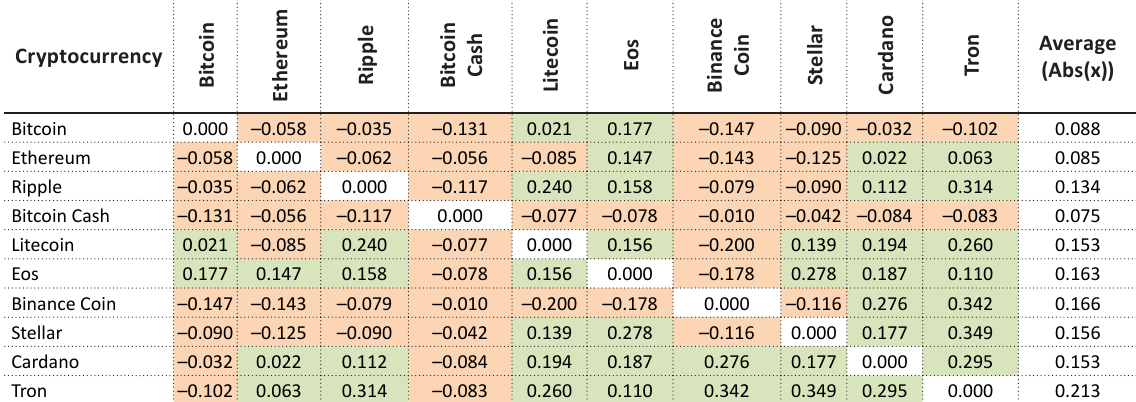
Table 6. Difference in value of correlation coefficients for the entire period, using daily and weekly